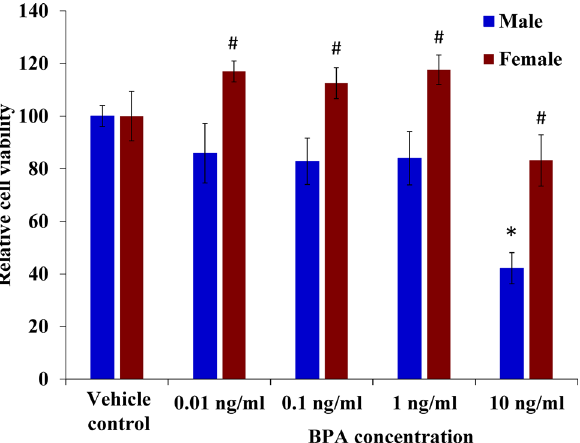
Figure 2. Effect of direct BPA exposure on the viability of primary hippocampal cells. Primary hippocampal cells were isolated from male and female neonatal rat pups that were not exposed to BPA and treated with 0.01, 0.1, 1, or 10 ng/mL BPA or vehicle control for 48 h. MTS assays were then performed to determine the number of viable cells. * ,# P value < 0.05. *Indicates a statistically significant difference between the BPA treatment and the vehicle control groups. # Indicates a statistically significant difference between males and females treated with the same concentration of BPA. Data are presented as the mean ±